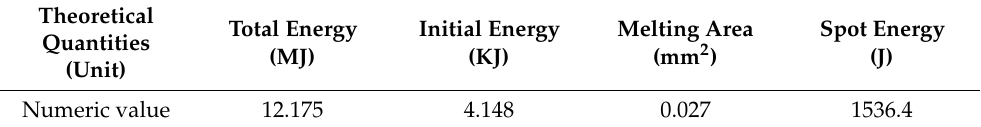
Table 5. Characteristic